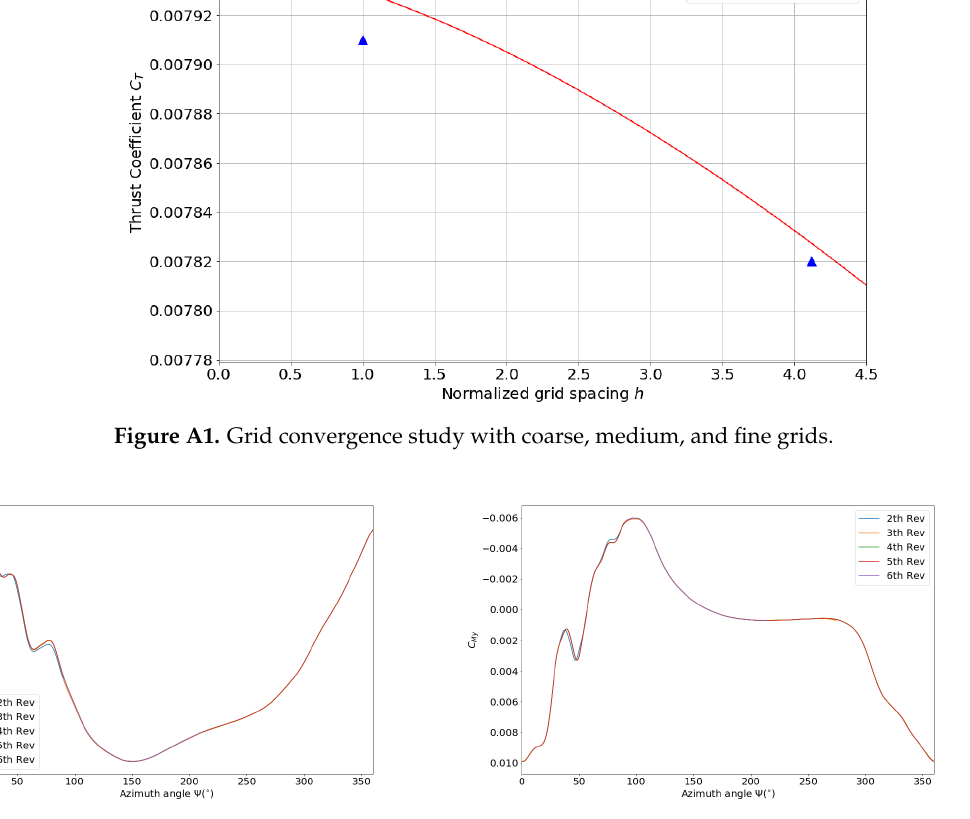
Figure A2. Superposition of force coefficients of different